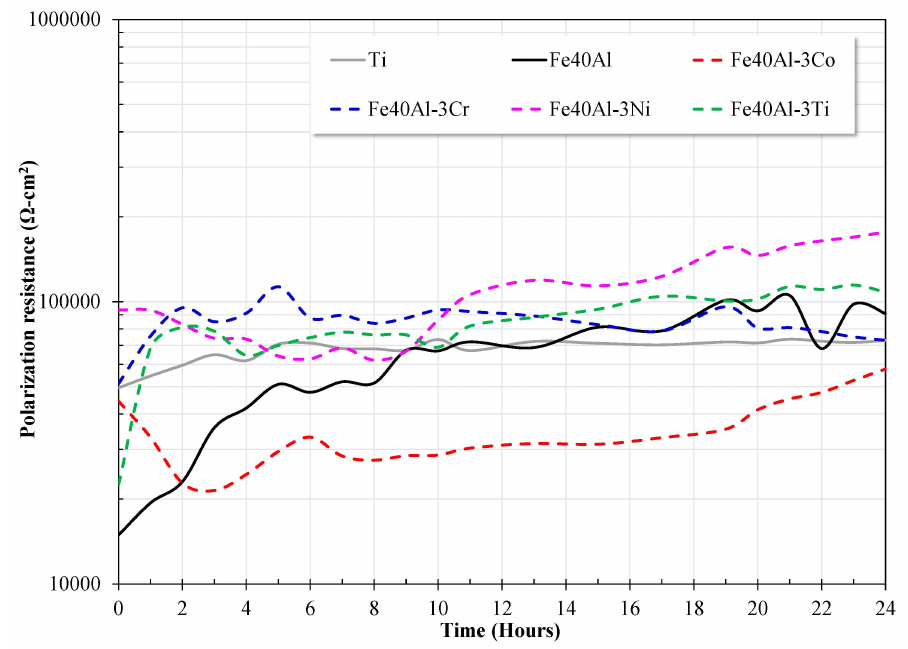
Figure 4. Variation of polarization resistance (Rp) of the evaluated alloys as a function of exposure period in artificial